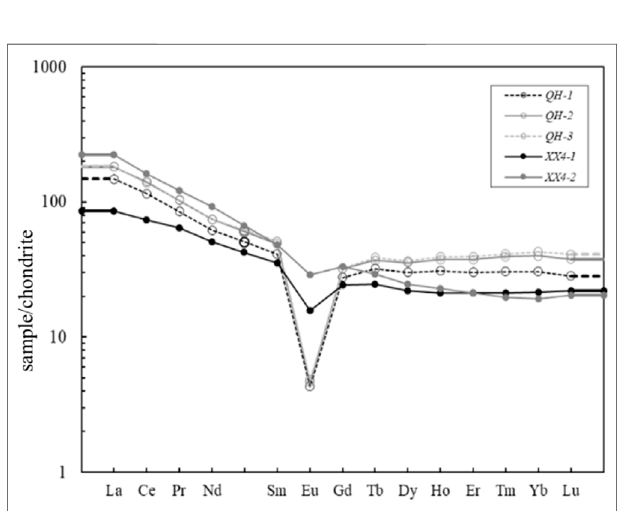
FIGURE 4 | Chondrite-normalized REE plot of